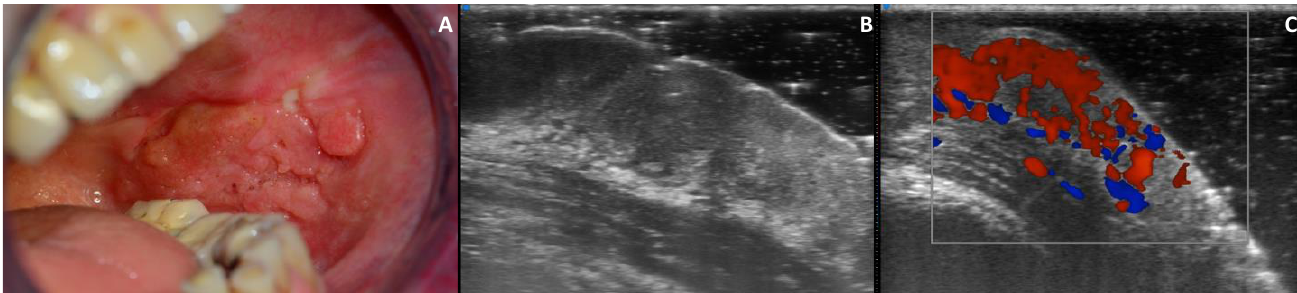
Figure 2. OSCC of the buccal mucosa in a 58-year-old female: ( A ) clinical aspect of the lesion; ( B ) B-mode UHFUS (ultra- high frequency ultrasound) examination, showing a hypoechoic exophytic lesion with irregular margins; the underlying submucosa appears to be thinned; ( C ) color Doppler image, showing moderate (score 2) intralesional vascularization.